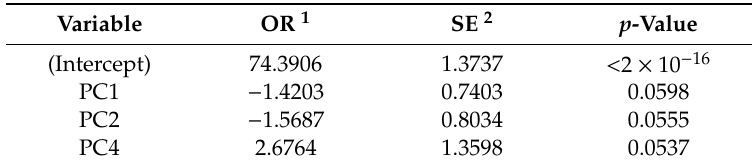
Table 2. Multivariate linear regression for selected components of Principal component (PC) analysis as they relate with food preference by kennel cats.